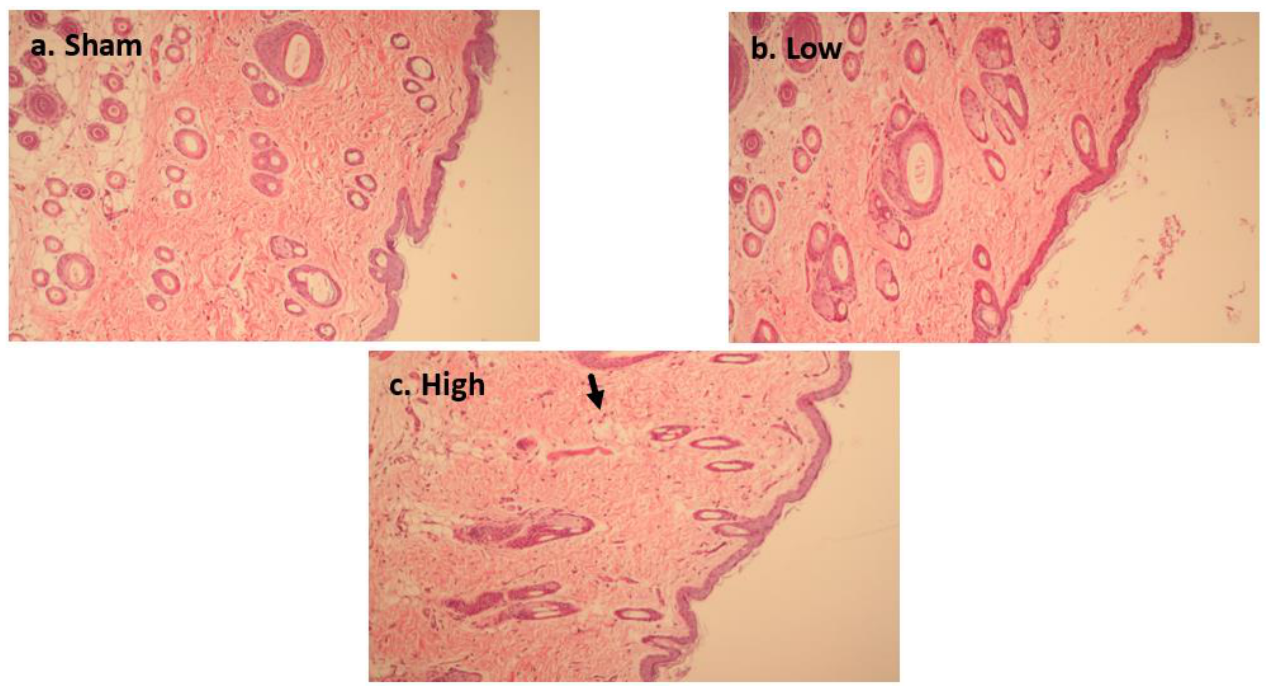
Figure 7. Effect of tDCS-iTBS on cortical tissue morphology (H&E staining) during short-term stimulation ( n = 15); ( a ) sham stimulation, ( b ) low-intensity stimulation (2.5 mA/cm 2 ), and ( c ) high-intensity stimulation (4.5 mA/cm 2 ).